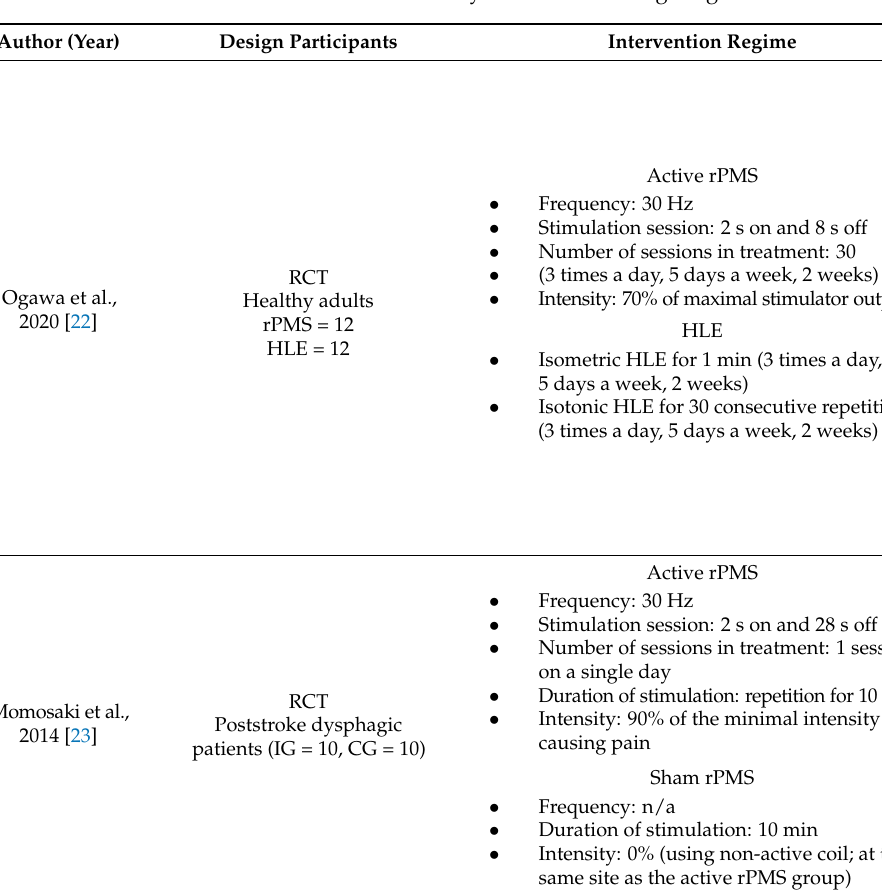
Table 2. Summary of studies investigating the use of